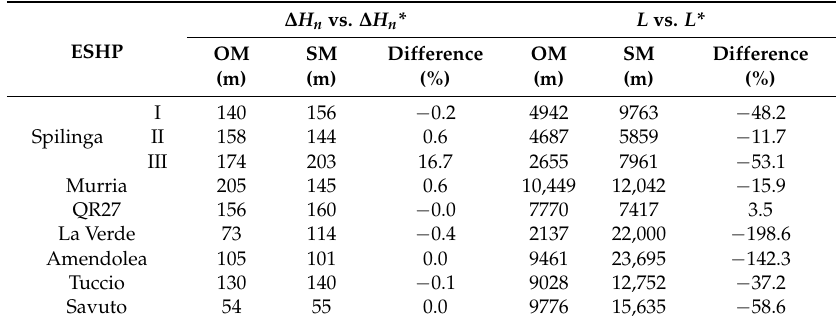
Table 4. Comparison of the net hydraulic head ( ∆ H n and ∆ H n * ) and pipeline length ( L and L* ) given by the original (OM) and simplified (SM) methods, respectively, for evaluating SHP energy production in seven irrigation systems of Calabria (Southern